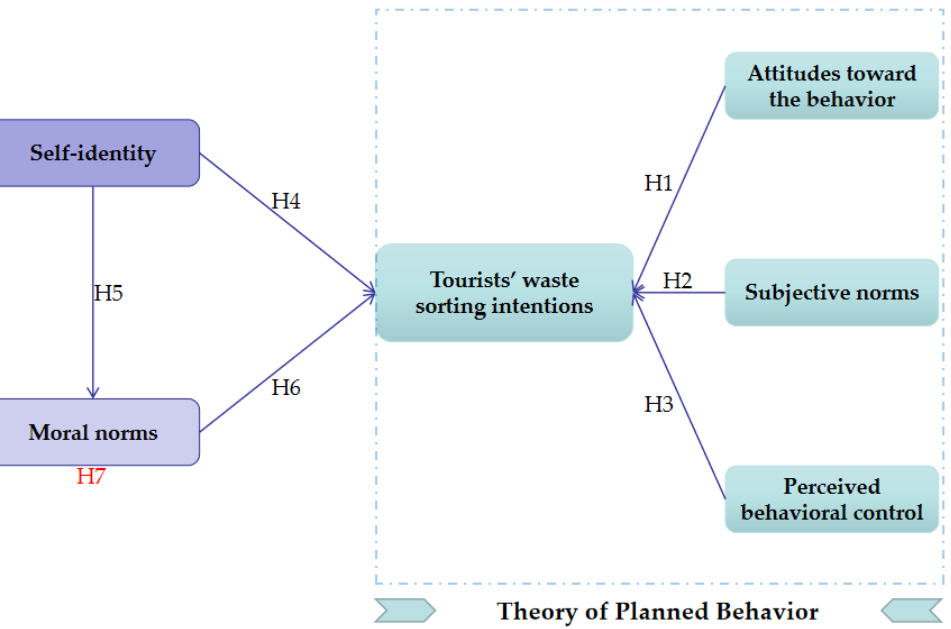
Figure 1. The proposed conceptual model of this research. Note: H1 − H6 are direct hypotheses, H7 is an indirect hypothesis.